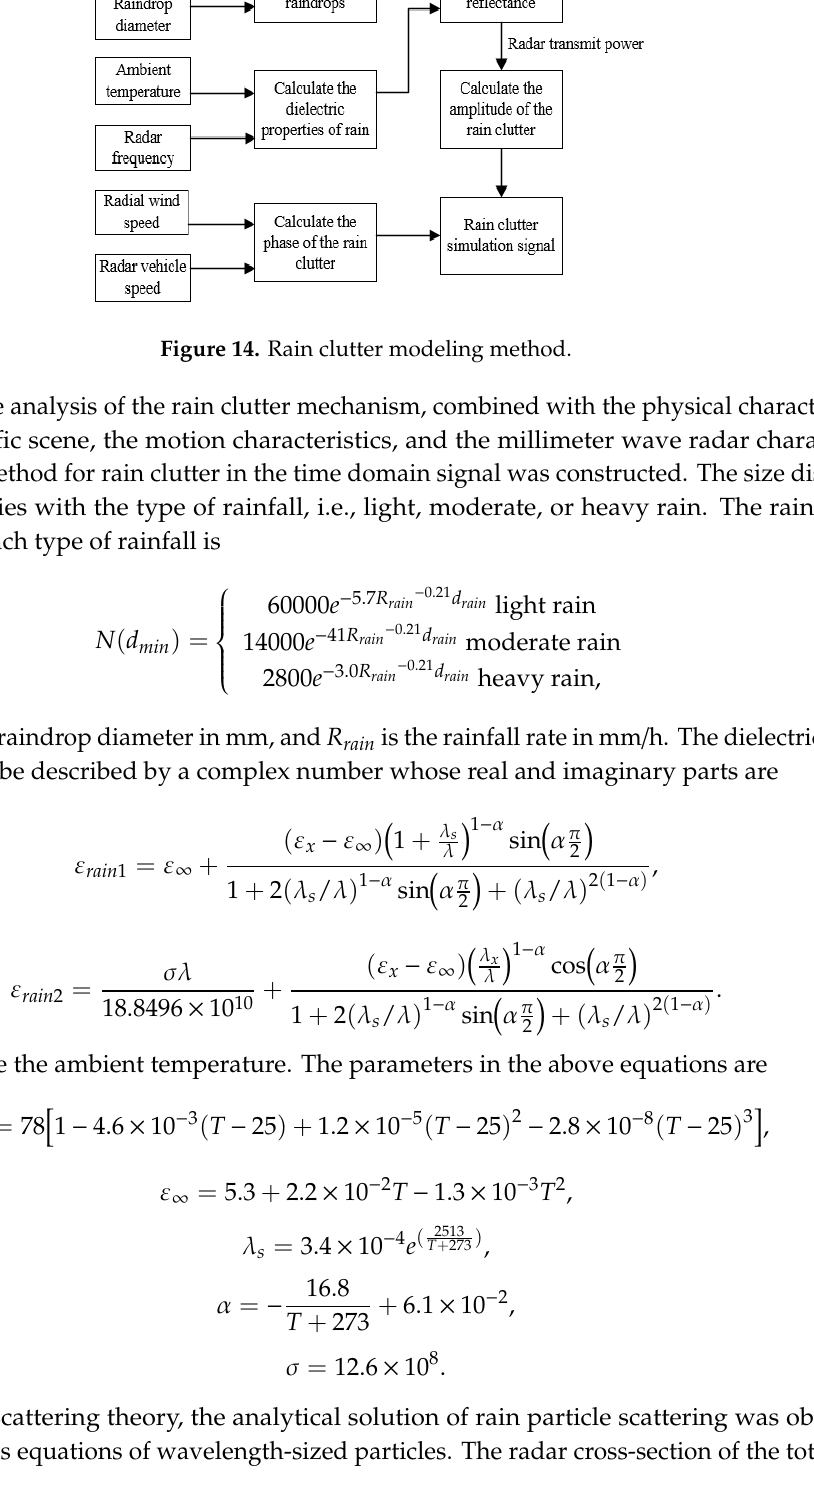
9 of 21 Figure 12. Ground clutter modeling method used to generate the Weibull distribution time domain signal. The comparison between the complex Weibull clutter generated by the ground clutter modeling method and the ideal Weibull curve is shown in Figure 13. It can be seen from this figure that the curve fitting effect of the model is better, and the injection effect of the strong scattering target of the two vehicles is also significant. Figure 13. Comparison of complex Weibull clutter and ideal Weibull curve generated by the ground clutter modeling method.